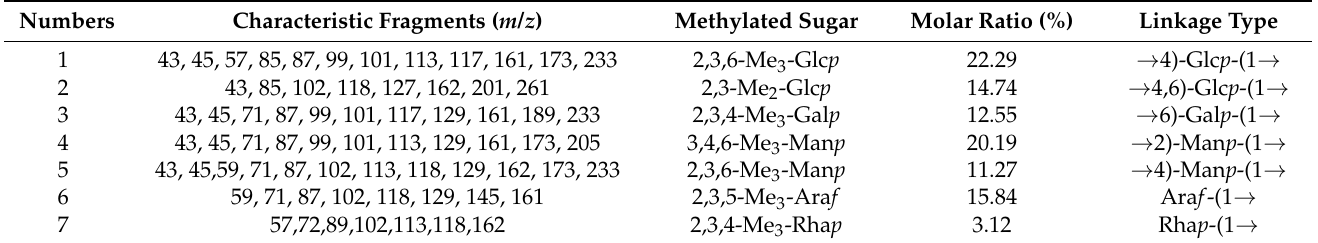
Table 1. Glycosyl linkage analysis of DLP-3.